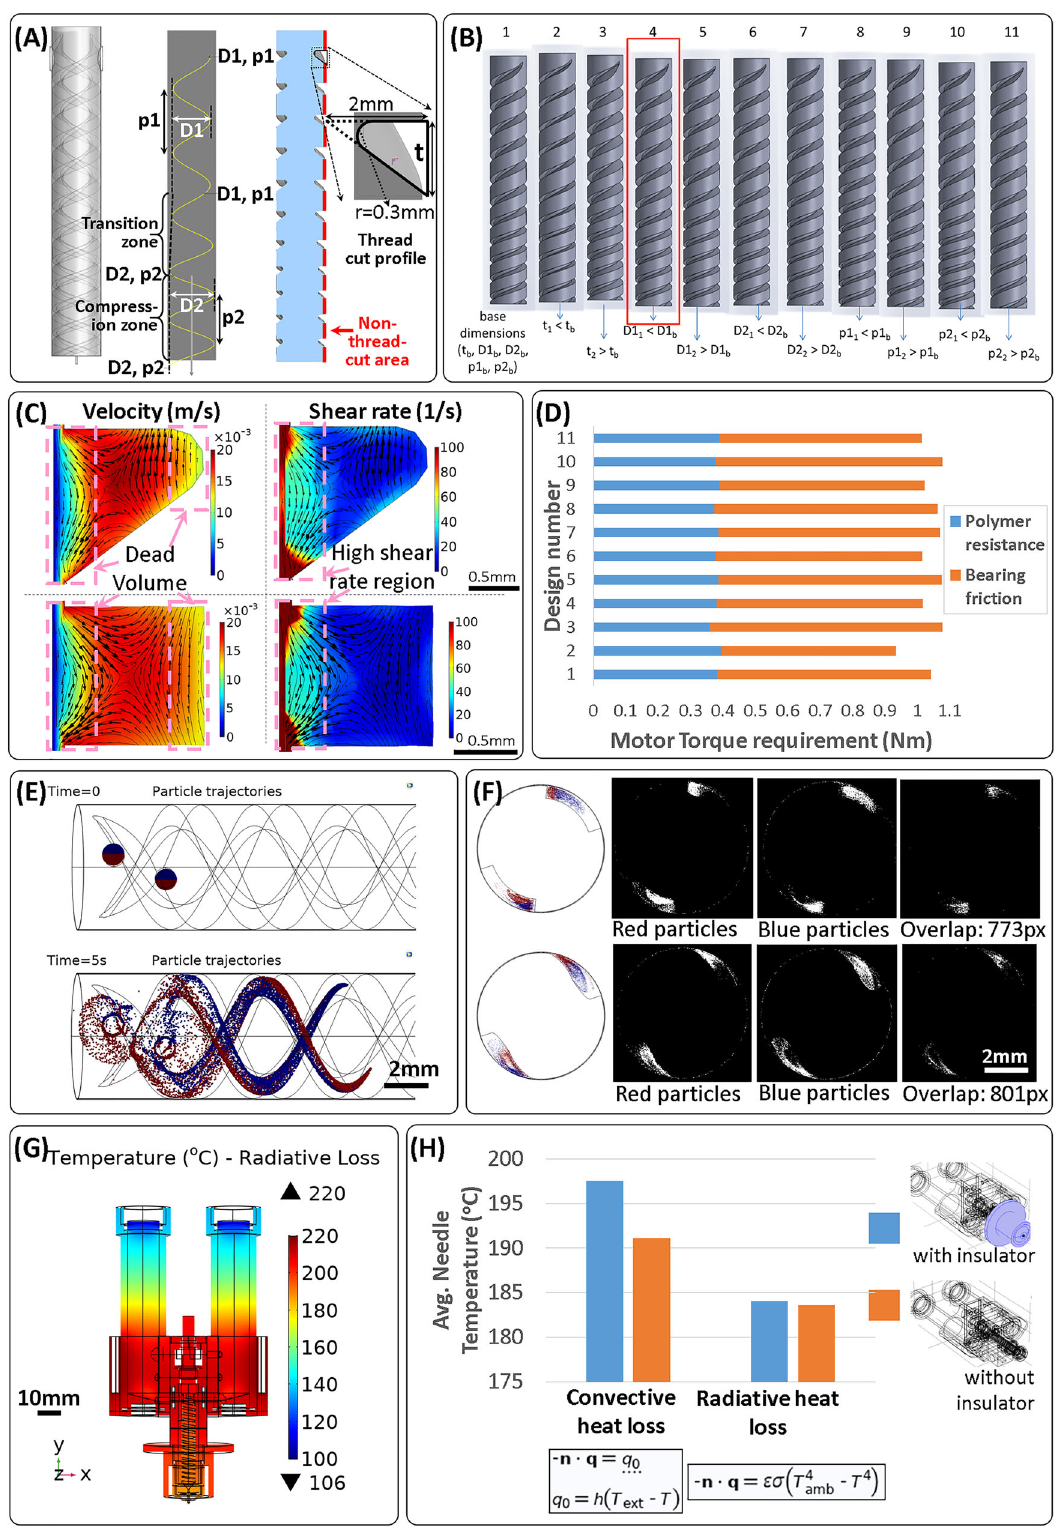
additionally generates elongational fl ows as the material is squeezed into a smaller space, contributing to mixing. Because of the triangular shape of the screw thread, reducing the cut depth also reduced the cut width, thus increasing the uncut area on the screw. This was used to increase the total thread length by including more thread coils by reducing the thread pitch, i.e.,